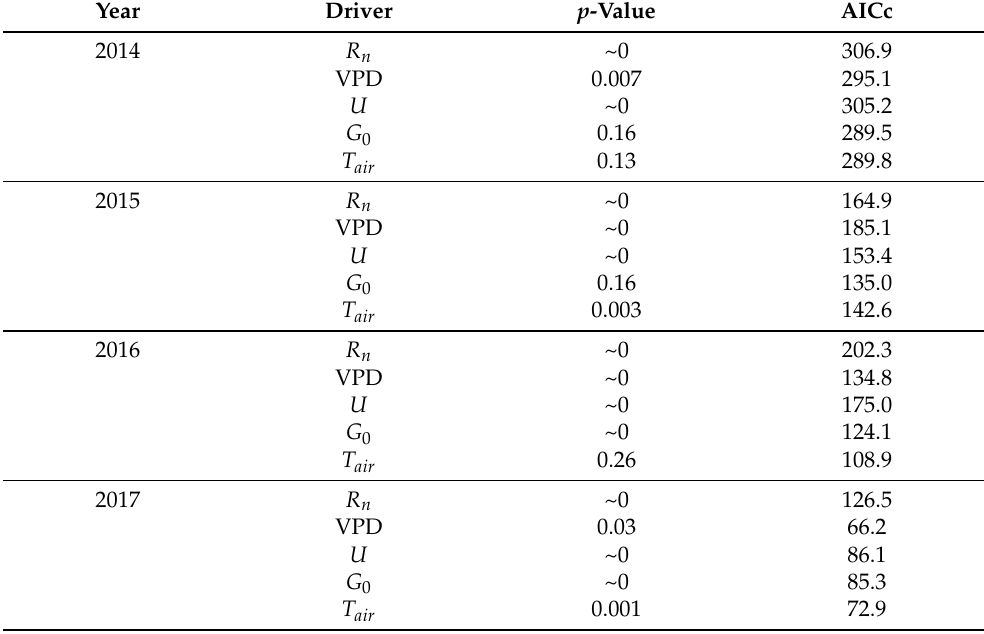
Figure A5. Mean diurnal cycles of daytime sensible heat flux ( H ), vapour pressure deficit (VPD), relative humidity (RH) and wind direction for the four growing seasons. Half-hourly data. ( a ) 2014. ( b ) 2015. ( c ) 2016. ( d ) 2017. Table A3. Results of the multivariate regression of actual evapotranspiration against the considered drivers. p -Values for Student t (threshold set to 0.05) and Akaike information criterion corrected for small sample sizes (AICc) values for each growing season. Illustrated AICc values are prior to AICc stepwise